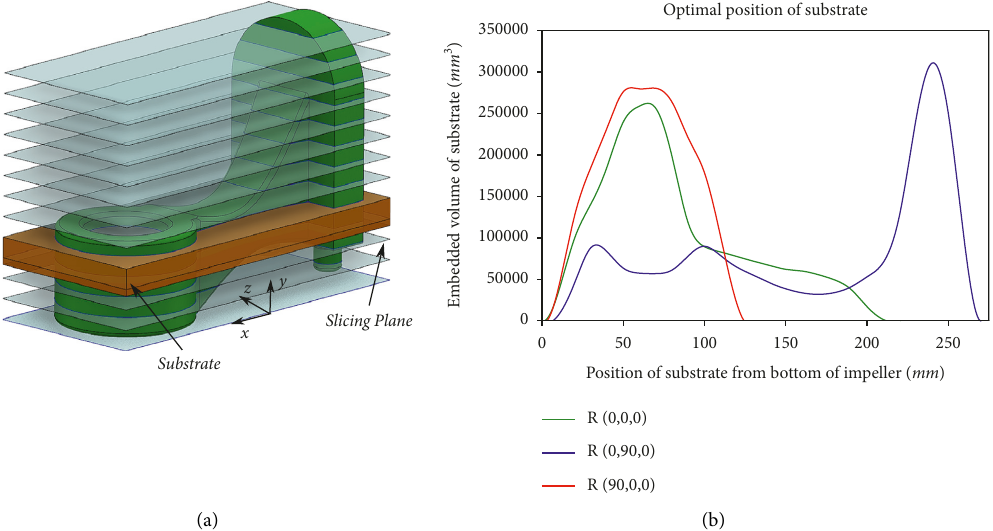
Figure 8: Illustrative example 5: (a) CAD model and (b) VI for different positions of the substrate with different